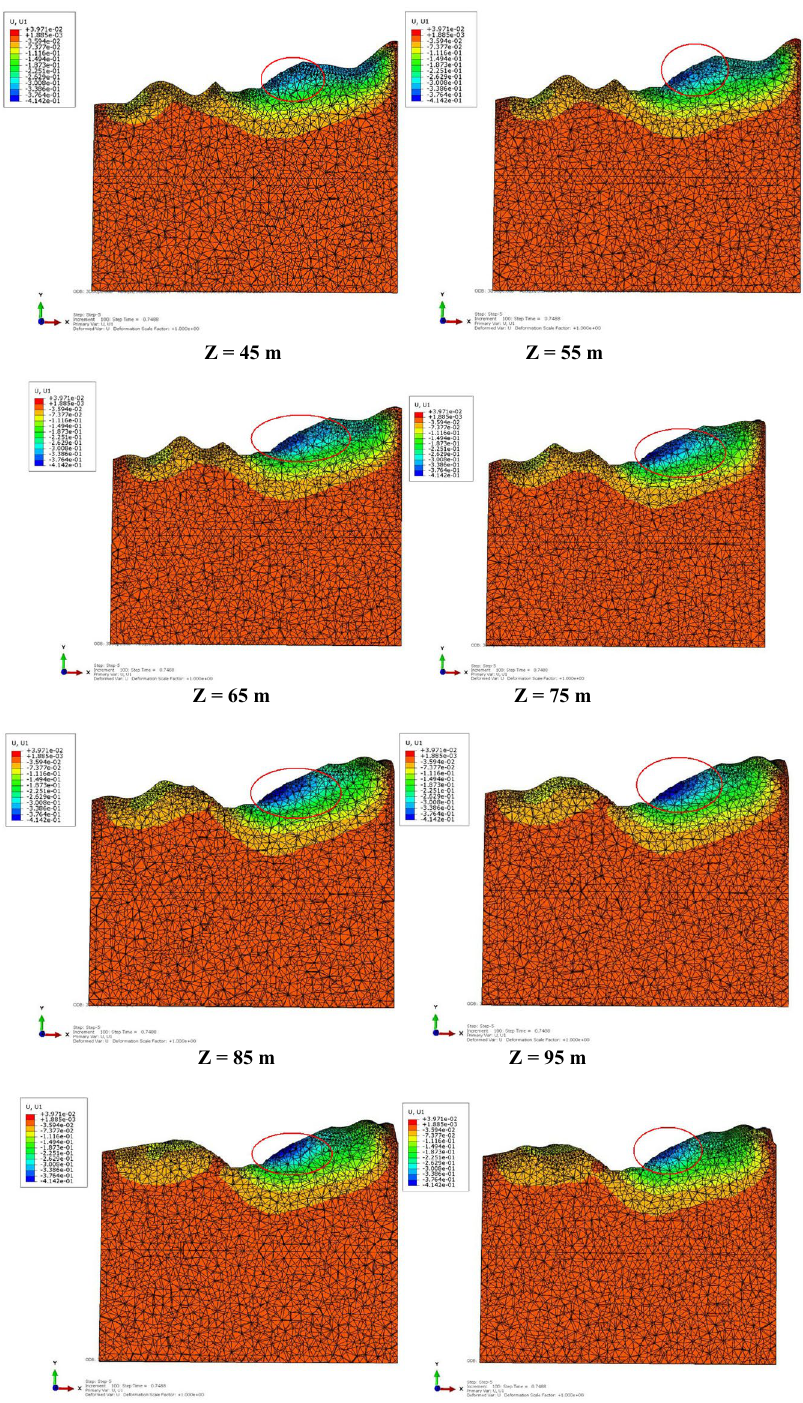
Figure 25. Displacement in the x direction between 45 and 115